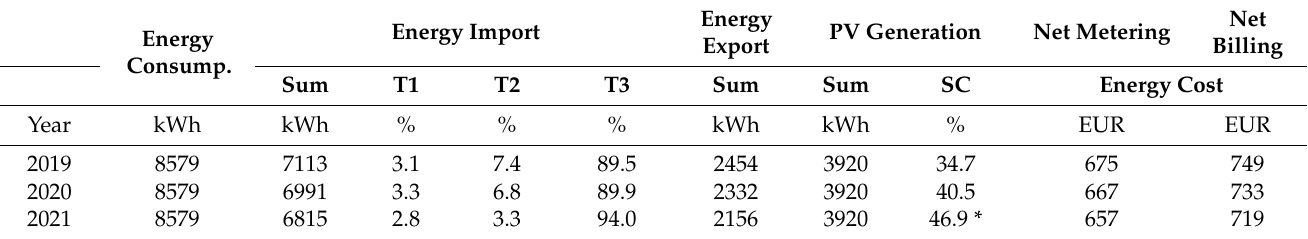
Table 9. Energy cost in tariff G13 before and after introducing the HEMS in 2019 and the ESSS in 2021. Energy